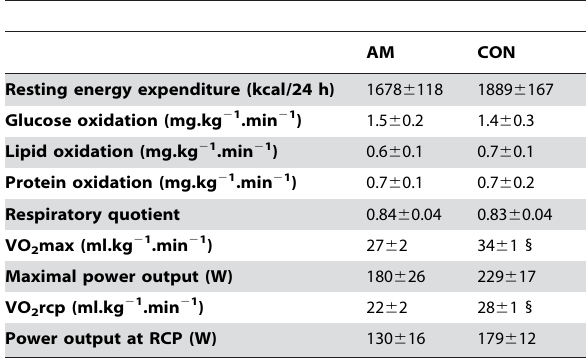
Table 2. Expired gas analysis during resting (indirect calorimetry) and exercise (spiroergometry).